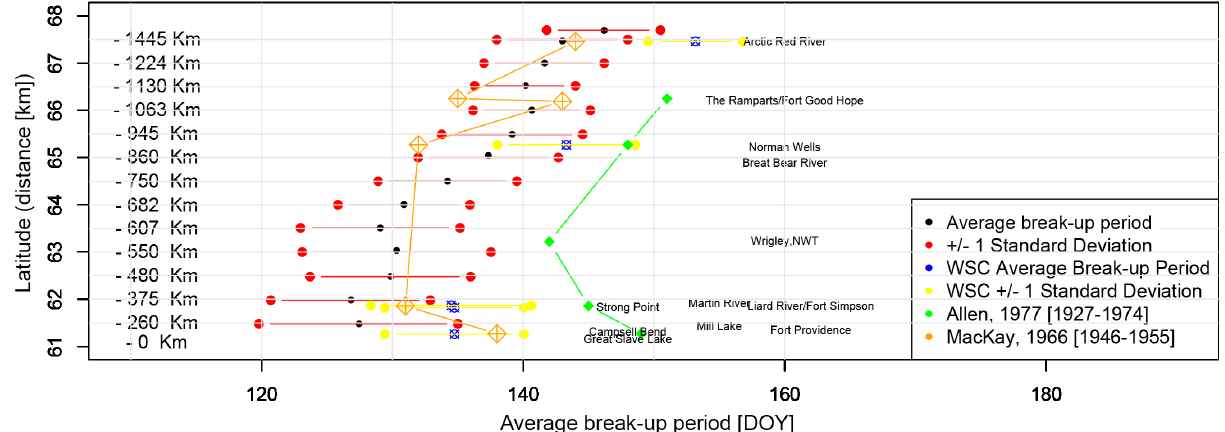
Figure 5. Average ice break-up dates estimated from MODIS (2001–2013) are given by the black dots, with ± 1 standard deviation indicated by red dots. The blue dots illustrate the WSC average ice break-up dates and the yellow dots ± 1 standard deviation. The green and orange dots represent average ice break-up dates from Allen (1977) from the time period of 1927–1974 and MacKay (1966) from the time period of 1946–1955